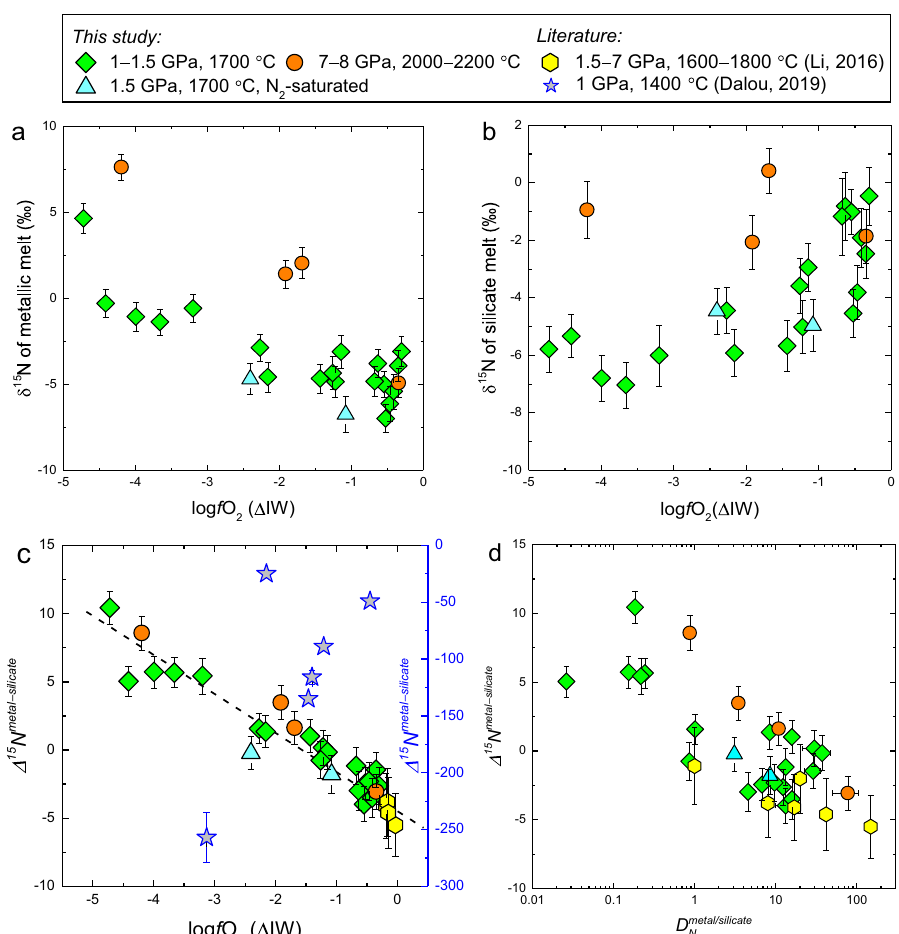
Fig. 3 | The N-isotopic composition ( δ 15 N) ofthe metallic and silicate melts and metal/silicateN-isotopicfractionation( Δ 15 N metal-silicate ).a The δ 15 Nofmetallicmelt increase with decreasing f O 2 . b The δ 15 N of silicate melt generally decrease with decreasing f O 2 . c The Δ 15 N metal-silicate of this study and Li et al. 35 are consistent and mainlycontrolledby f O 2 .InthestudyofDalouetal. 36 , Δ 15 N metal-silicate varyfrom − 49 ‰ to − 257 ‰ (thegray- fi lledbluestarsandright-handblueYaxis).ThelargeN-isotopic